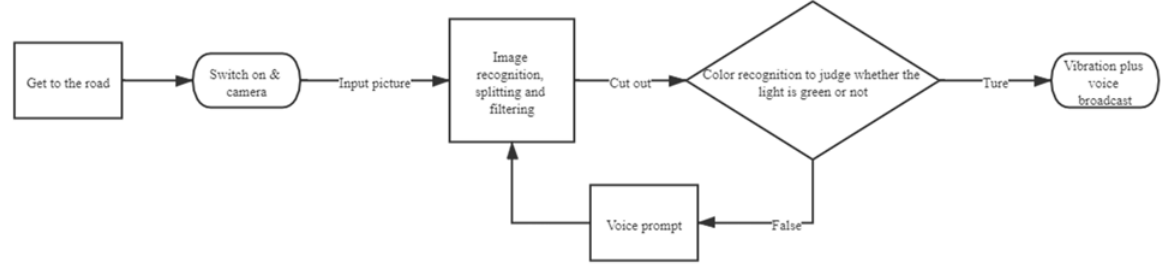
Appl. Sci. 2021 , 11 , x FOR PEER REVIEW Figure 2. The HCI logic diagrams of identifying the traffic lights and the text content. Figure 2. The HCI logic diagrams of identifying the traffic lights and the text content. Figure 2. The HCI logic diagrams of identifying the traffic lights and the text content.